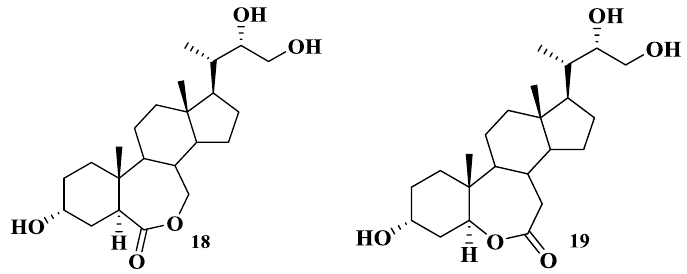
Figure 3. New 2-deoxybrassinosteroids analogs ( 18 and 19 ) with 3α-hydroxy-24-nor-22,23-dihydroxy-5α-cholestane side chain type.